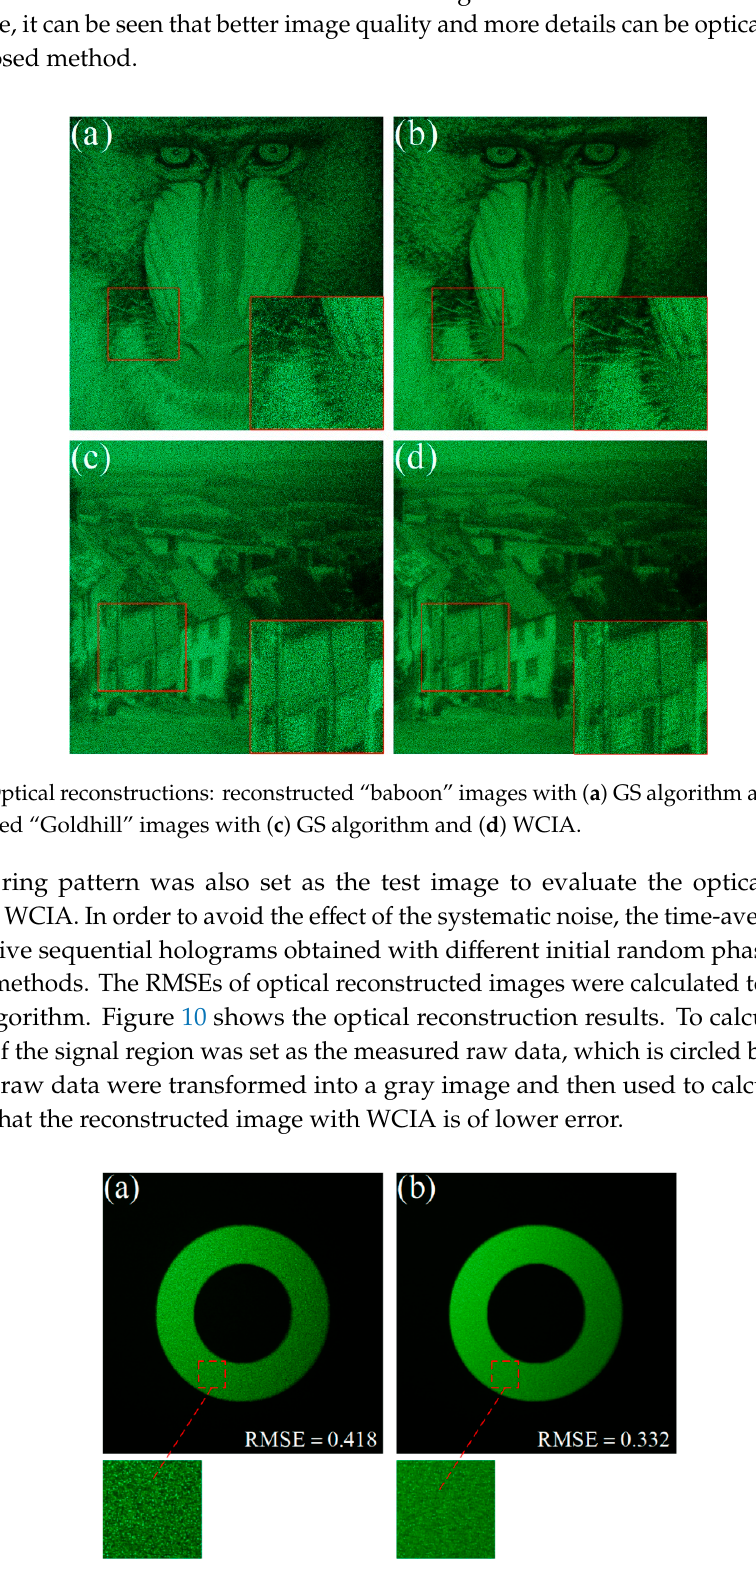
Figure 10. Optical reconstructions: ( a ) GS algorithm; ( b ) WCIA.